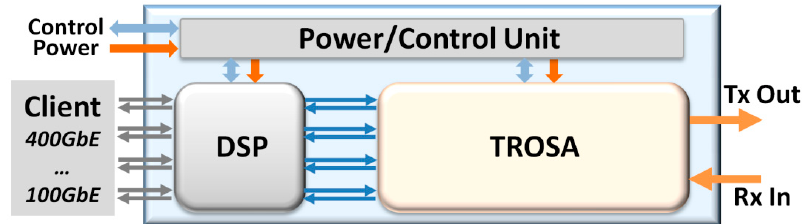
Figure 3. Typical architecture of 400G pluggable coherent transceiver. DSP: digital signal processing, TROSA: transmitter and receiver optical subassembly, Tx: transmitter, Rx: receiver. Coherent digital signal processing (DSP) power consumption evolution. CMOS: complementary metal-oxide-semiconductor.